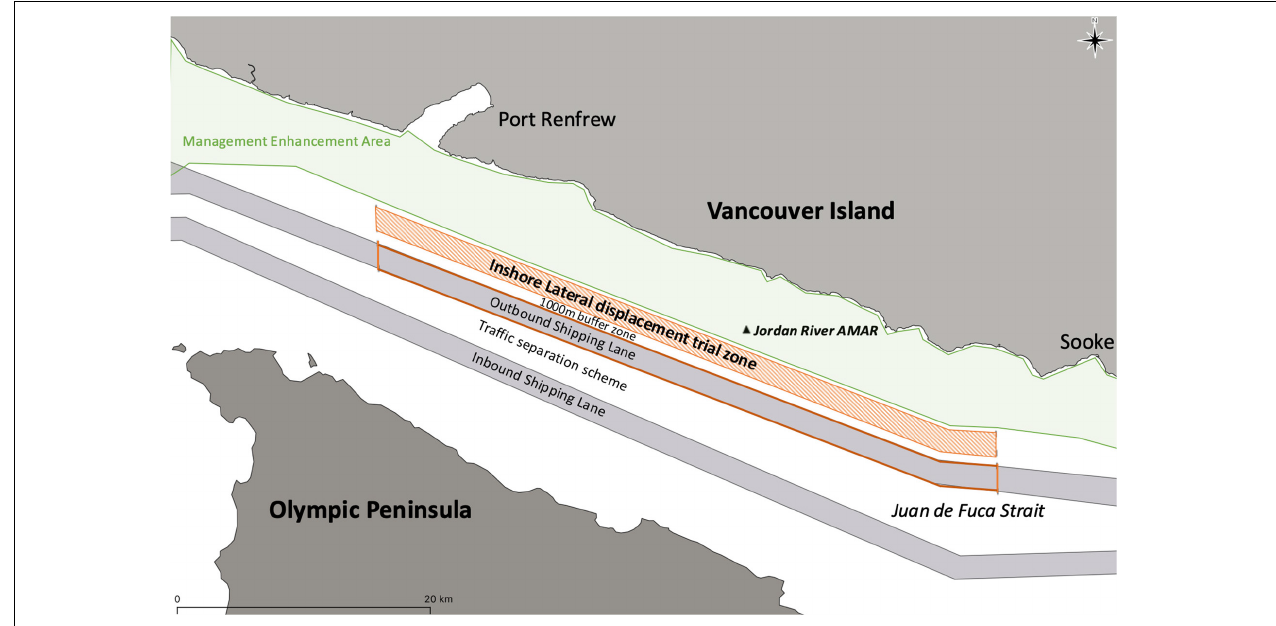
FIGURE 4 | The section of Juan de Fuca where tugs were requested to transit either in the 1500 m inshore lateral displacement zone or outbound shipping lane to take a more southern route. The hydrophone deployed at Jordan River used to assess the efficacy of this measure is shown as a black triangle and labeled as Jordan River AMAR.